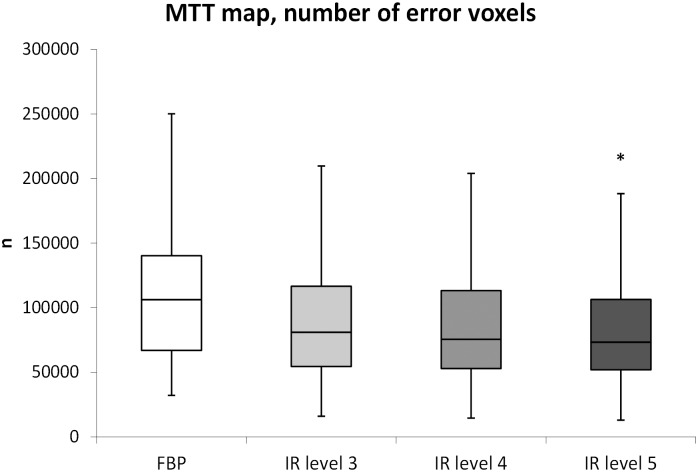
MTT map, number of error voxels.The amount of error voxels (i.e. voxels without perfusion information) was significantly reduced between FBP and IR level 5. (* p = 0.004).